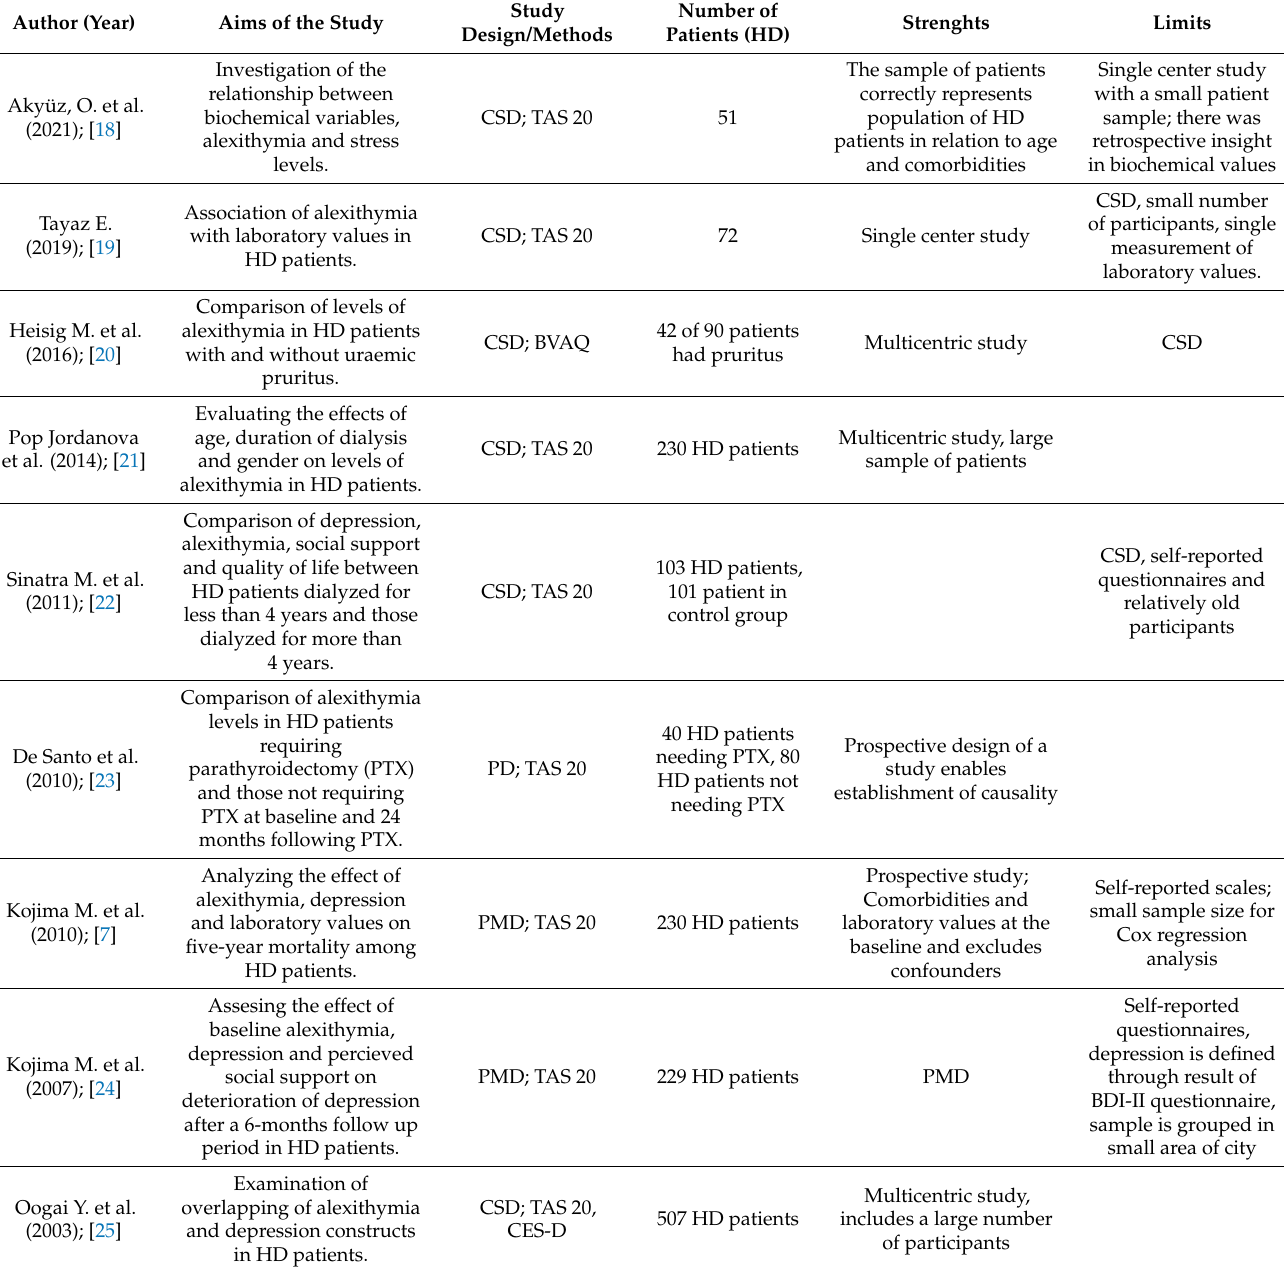
Table 1. Matrix of relevant literature. Hemodialysis (HD), Cross-sectional design (CSD), Prospective multicentric design (PMD), Prospective design (PD); Center for Epidemiological Study Depression Scale (CES-D). Author